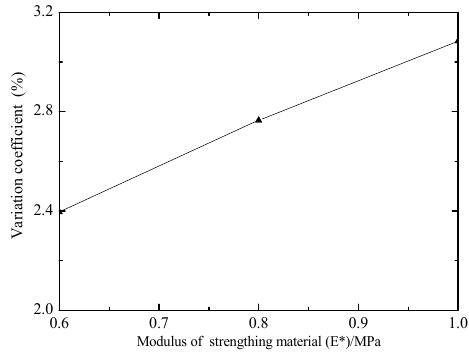
Figure 8. Effect of modulus of strengthening material on stress in central